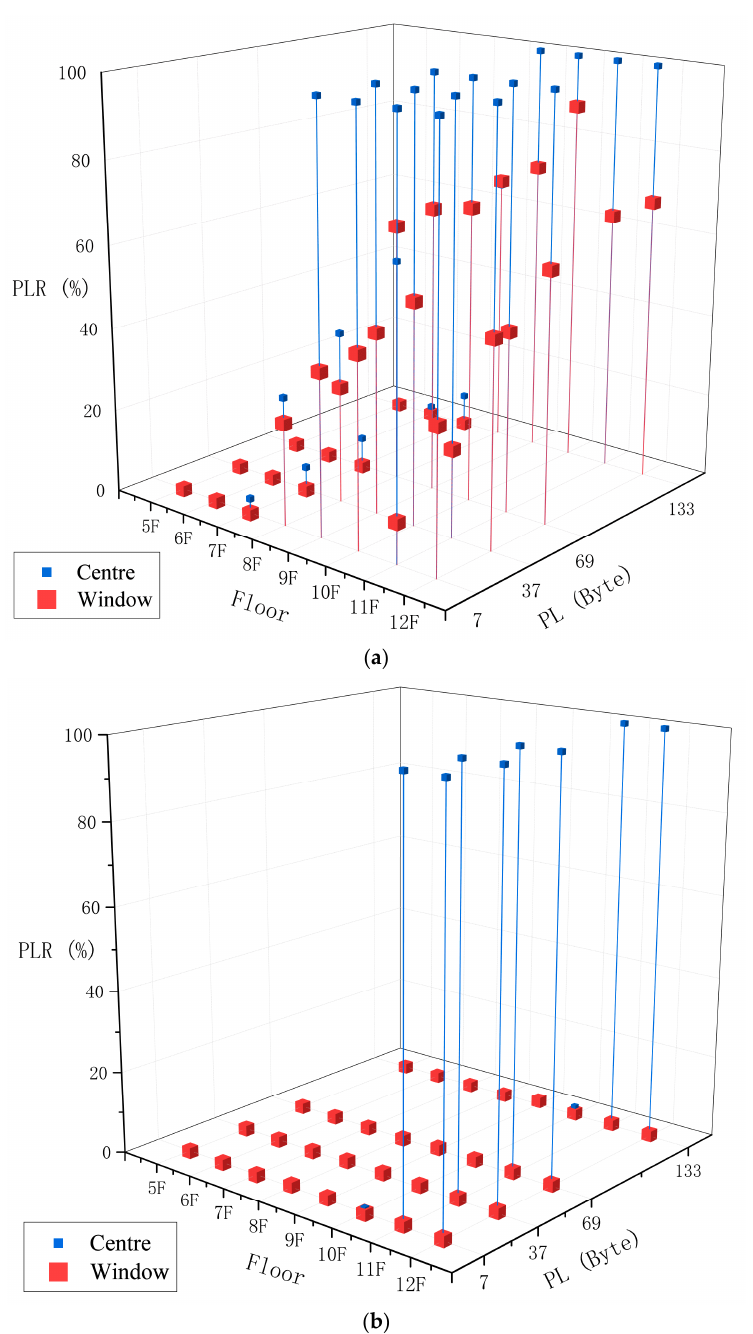
Figure 15. Comparison of PLR between central position and window position: ( a ) ZigBee; ( b ) LoRa.